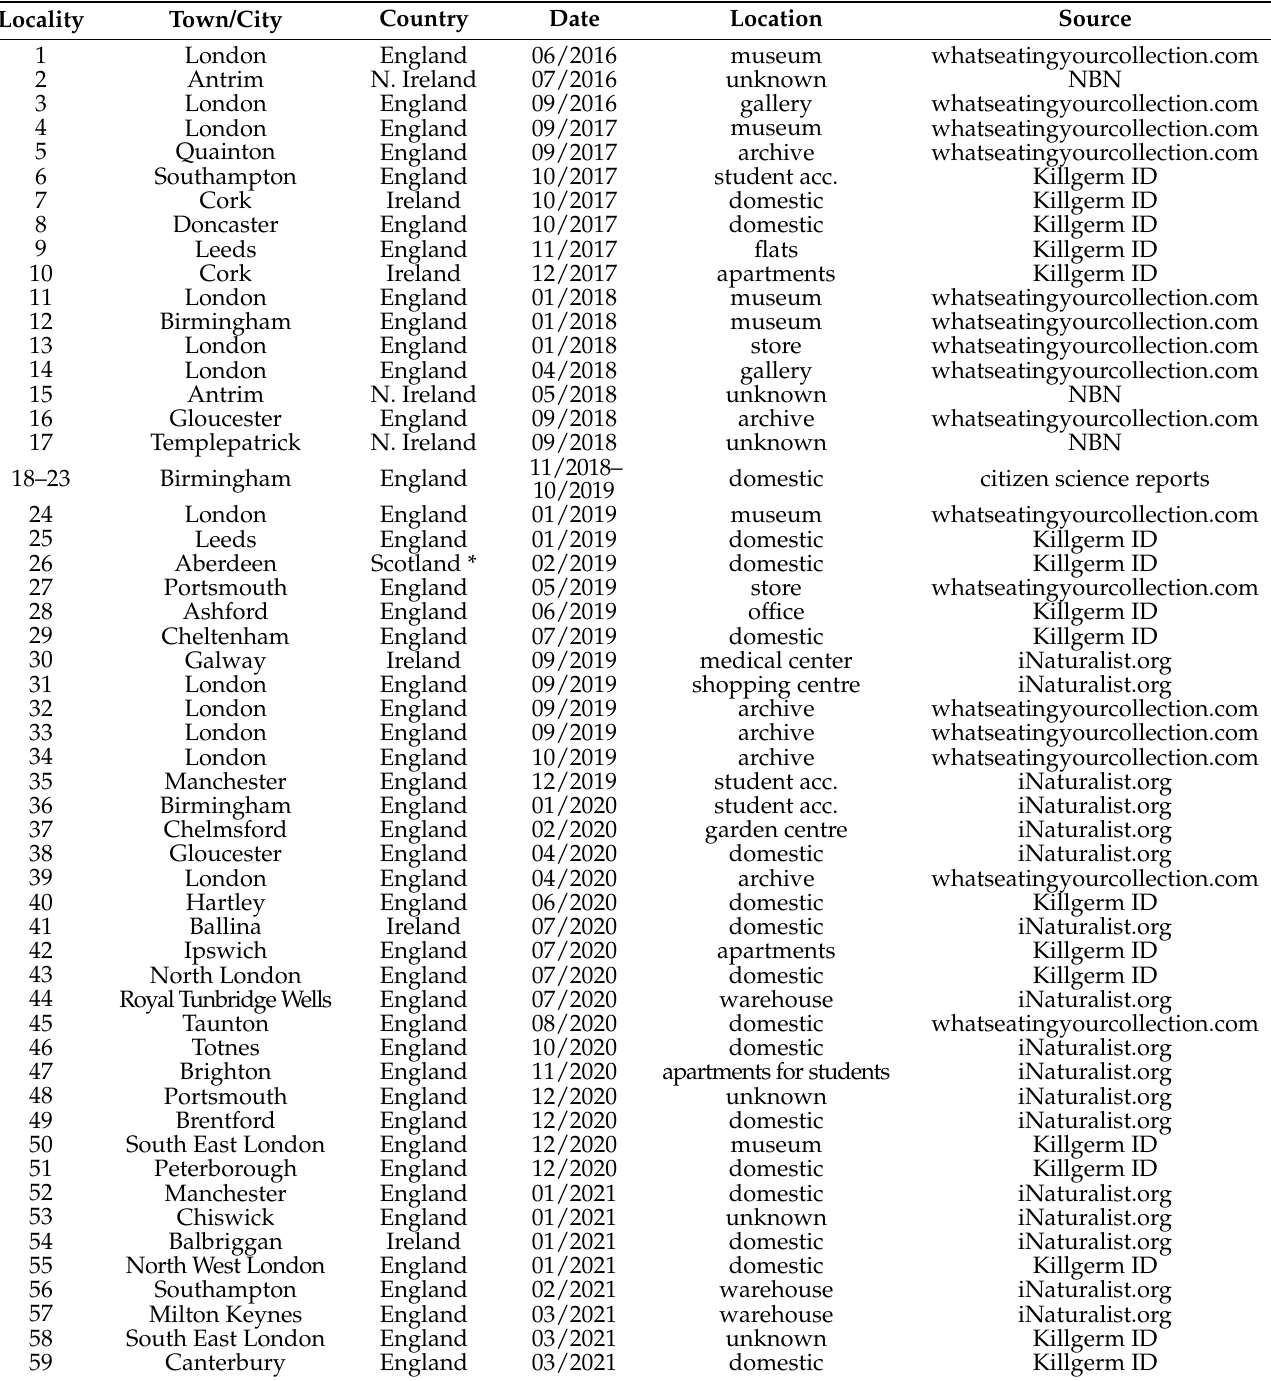
Table 3. The reported occurrence Ctenolepisma longicaudatum in the United Kingdom and Republic of Ireland in 2016–2021.